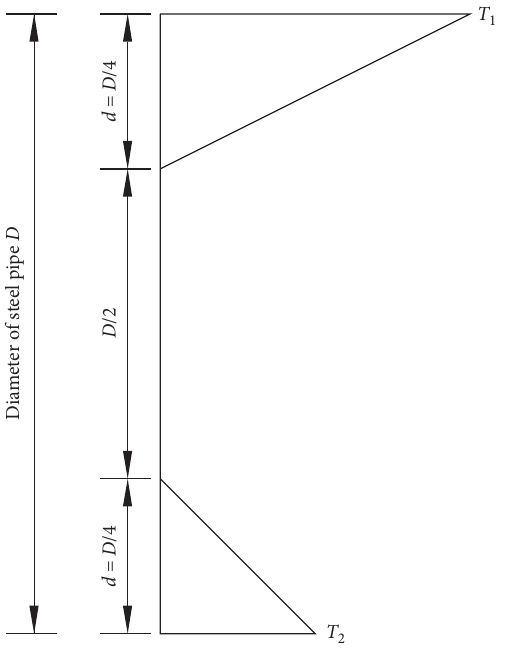
Figure 5: Gradient temperature difference curve as per the Chinese code.